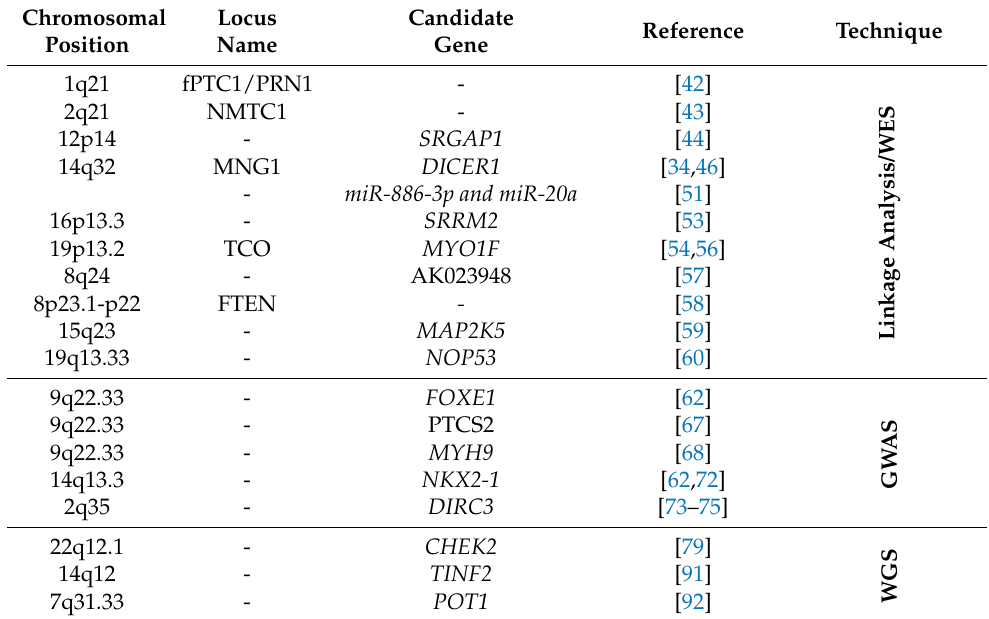
Table 1. Susceptibility loci and candidate genes linked to NMTC. Chromosomal Locus Position